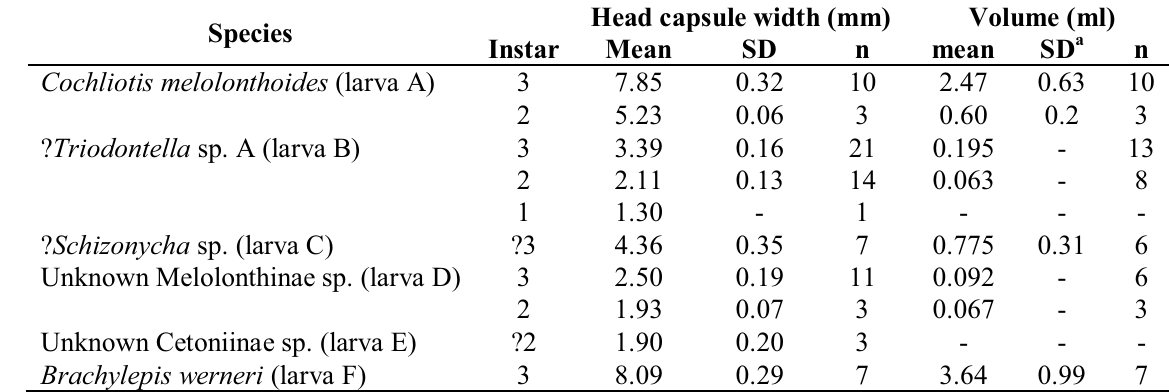
Table 9. White grub head capsule width and body volume measurements.